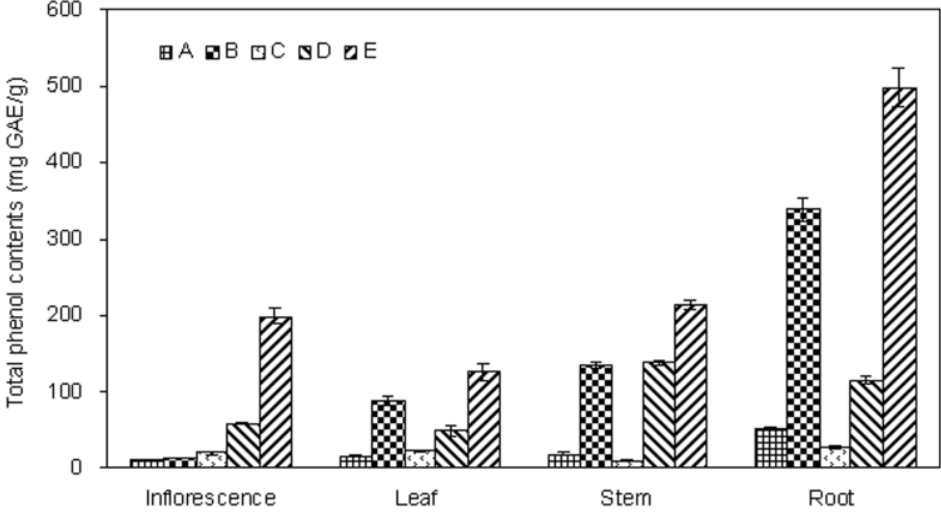
Figure 2. Total phenolics in fractions of different parts of E. ciliate